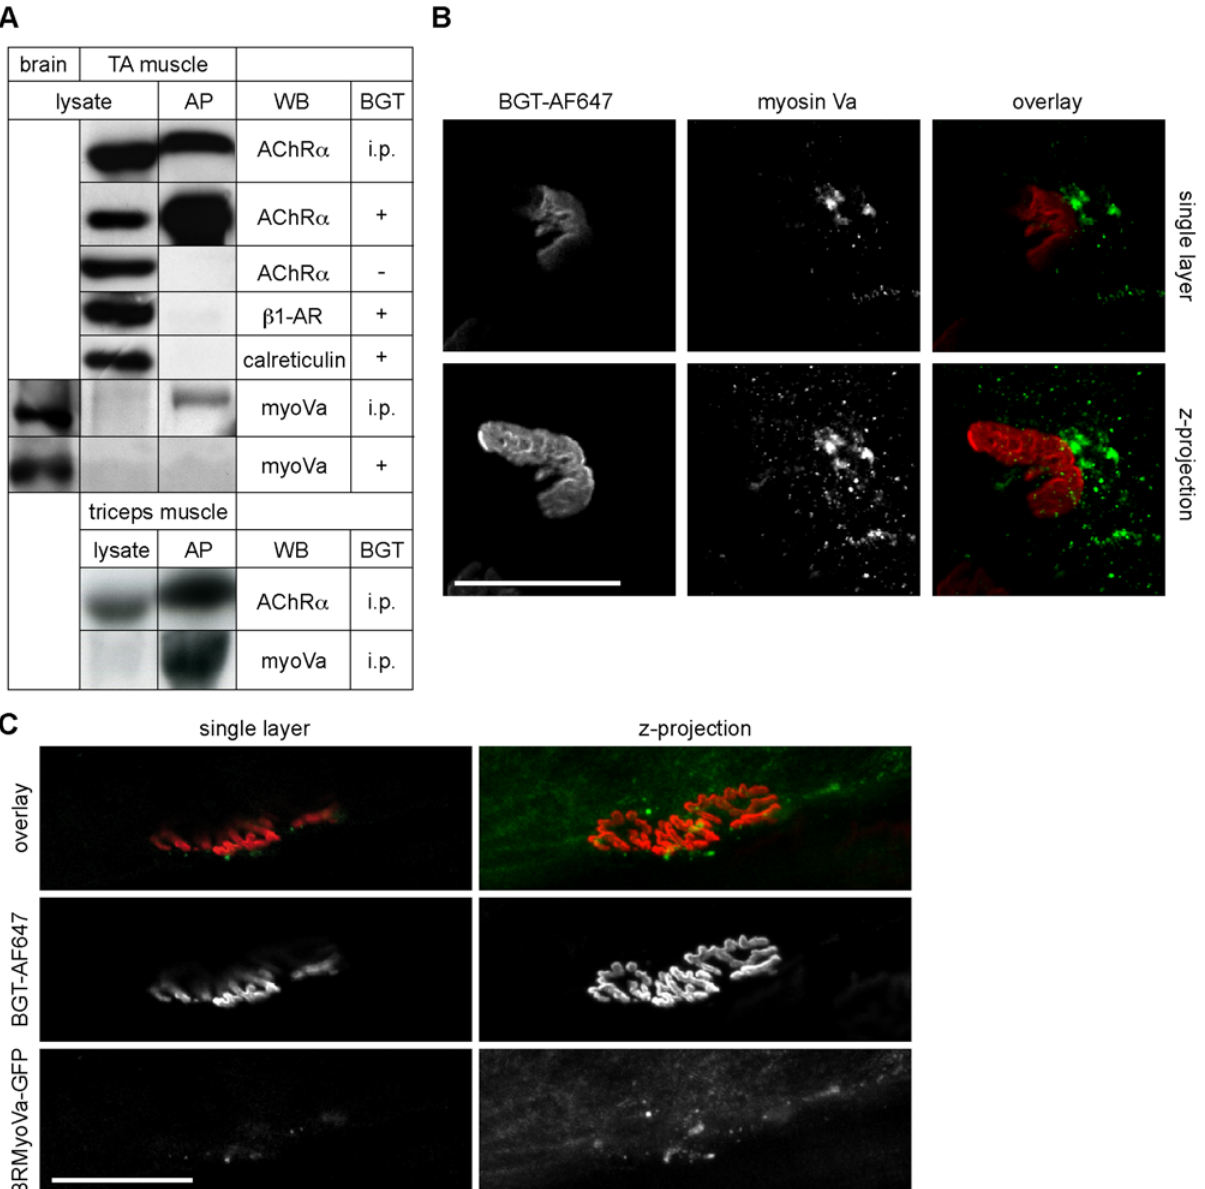
Figure 3. Myosin Va is enriched in punctate structures in the postsynaptic region of skeletal muscle. A: Wildtype mice were intraperitoneally injected with BGT-biotin (BGT, i.p.) or left untreated. Then, lysates of brain as well as TA and triceps muscles (indicated) were prepared. Samples from untreated mice were incubated in the presence or absence of BGT-biotin (BGT, + or 2 , respectively). Then, all samples were incubated with NeutrAvidin beads and AChRs affinity precipitated. Bands, representative Western blot signals from lysates and affinity precipitates (AP) using antibodies against proteins as indicated (WB). B: Triceps muscles of wildtype mice (P20) were co-stained with BGT-AF647 and LF-18 myosin Va antibody and then imaged with confocal microscopy. Single confocal layer and corresponding maximum z-projection of 43 background- subtracted optical slices taken at 0.7 m m interslice distance encompassing the entire extension of the shown NMJ in depth. Overlay, BGT-AF647 (red), myosin Va antibody signal (green). Scale bar, 50 m m. C: TA muscles of adult wildtype mice were transfected with full length brain myosin Va-GFP (BRMyoVa-GFP). Ten days later, transfected muscles were locally injected with BGT-AF647 and then imaged with in vivo confocal microscopy. Single layer and corresponding maximum z-projection of 29 optical slices taken at 0.7 m m interslice distance encompassing the entire extension of the shown NMJ in depth. Overlay, BGT-AF647 (red), myosin Va-GFP (green). Scale bar, 50 m m.